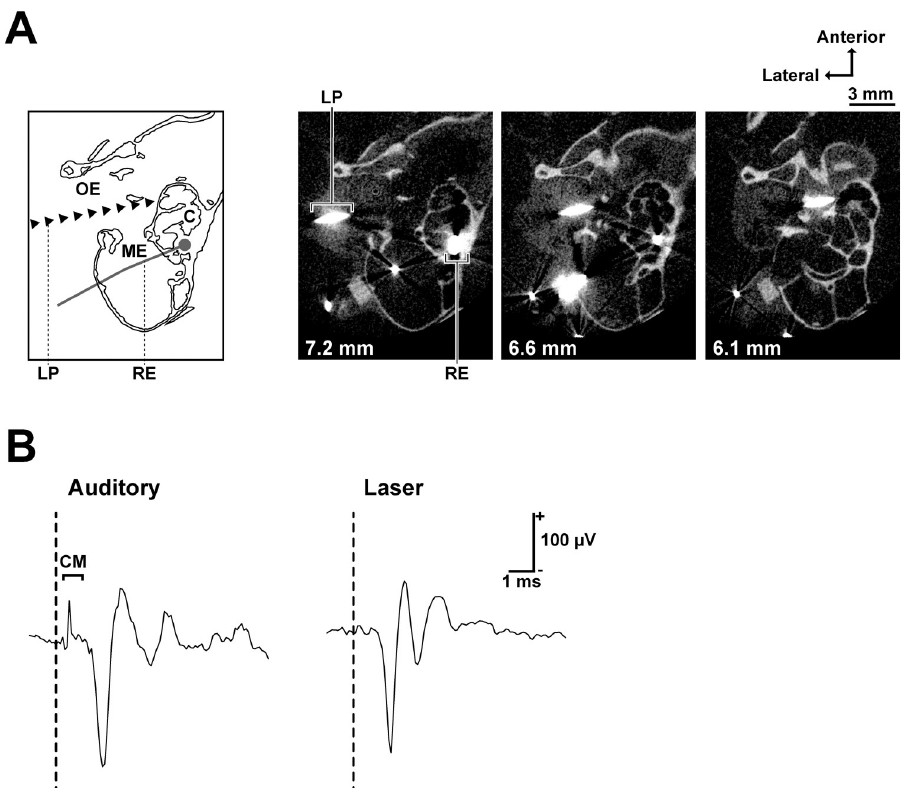
Fig 1. Laser irradiation site and the cochlear responses to laser and auditory stimuli. (A) Schematic of recording and stimulation configuration (the left-most) and microcomputed tomography images of a stimulated cochlea (horizontal section). The distance from the sagittal suture is stated on the bottom left of each image. The recording electrode (silver wire) and the laser path (tungsten wire) are shown as larger than their actual sizes due to metal artifacts in CT images. (B) Cochlear responses to auditory (100 μ s single click with 70 dB peak-to-peak equivalent SPL) and laser (100 μ s single pulses, 4.9 mJ/cm 2 ) stimuli. A clear cochlear microphonic (CM) was observed only after the auditory stimulus. The vertical dashed lines show stimulus onset. Abbreviations: OE, outer ear; ME, middle ear; C, cochlea; LP, laser path; RE, recording electrode; CM, cochlear microphonic.